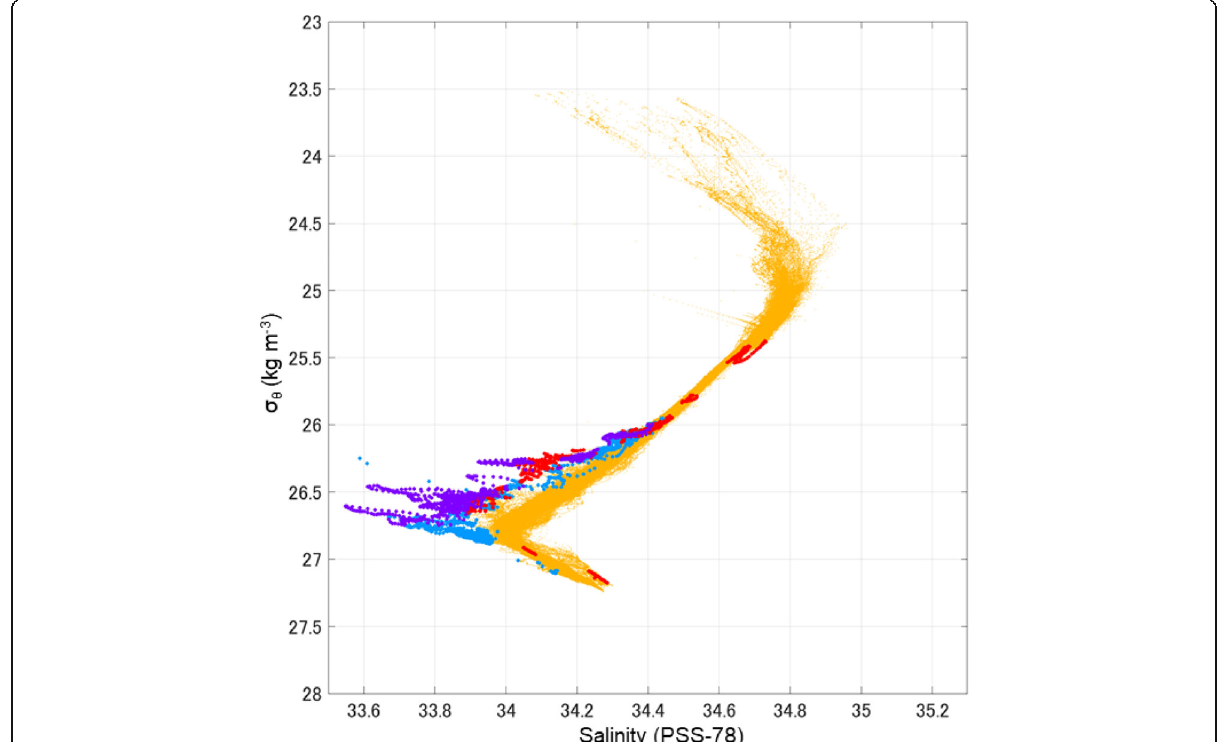
Fig. 9 σ θ -S diagram of the Seaglider data, colored with over 3 σ of negative salinity anomaly (blue circles), positive DO anomaly (red circles), and both (purple circles) below 400 dbar during Apr. 28 – May 13. Orange dots represent all Seaglider data for Feb. 27 – Jun.